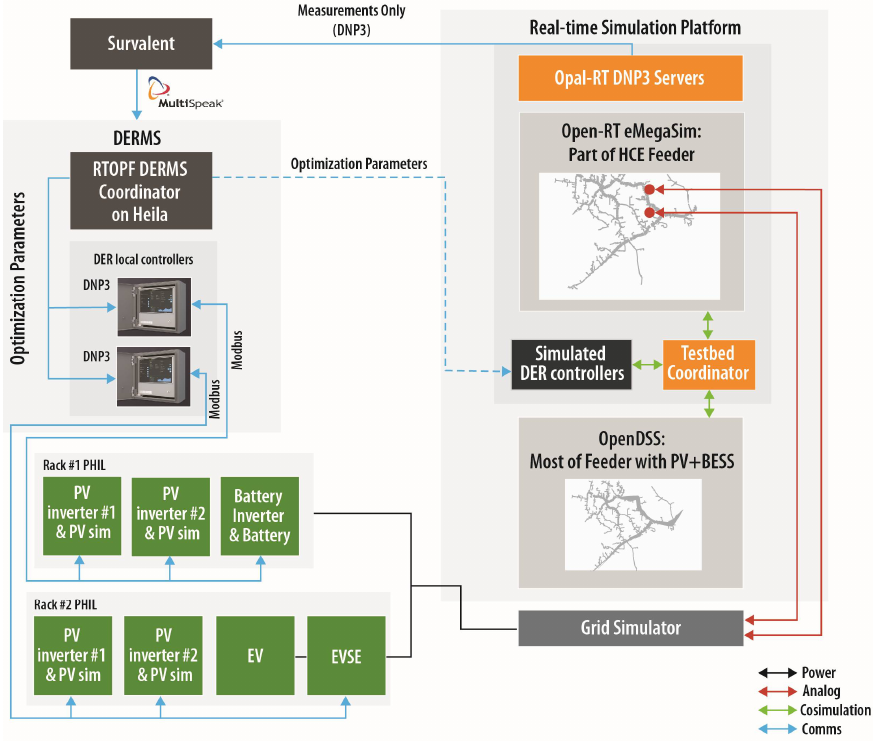
Figure 2. Schematic diagram of the HIL platform of the example project.